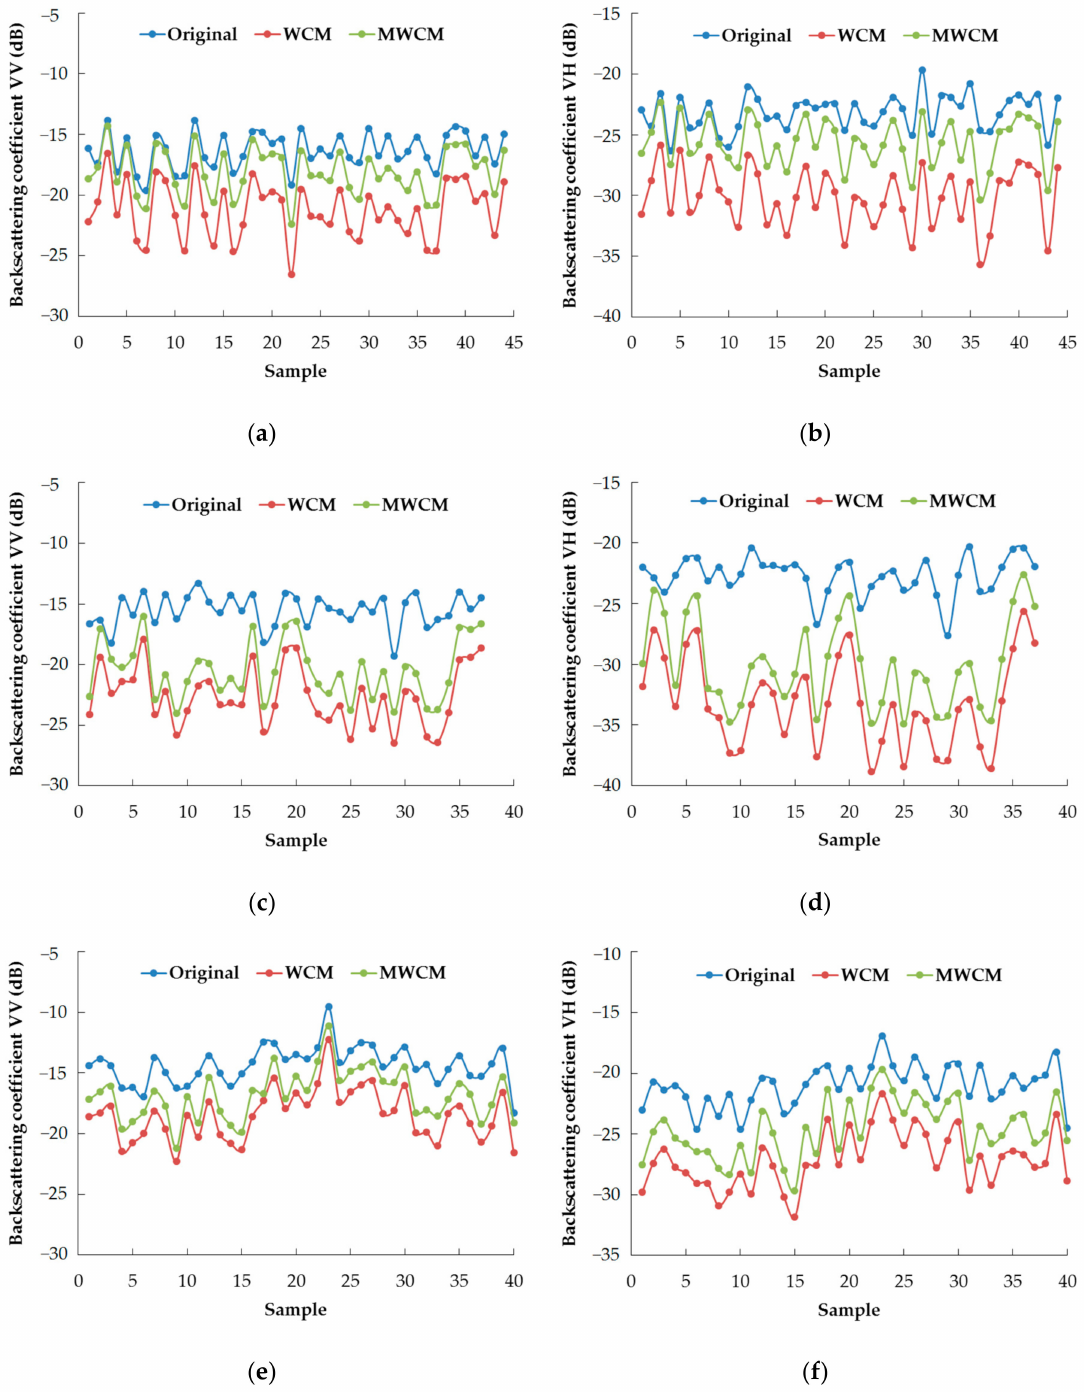
Figure 5. The VV/VH polarization backscattering coefficients before and after the removal of vegetation influence in different phases: ( a , b ) 14.4.2013; ( c , d ) 15.5.2013; ( e , f ) 1.6.2013. The blue dots represent the original radar backscattering coefficients, while the red dots and green dots represent the radar backscattering coefficients after the removal of vegetation influence by WCM and MWCM,